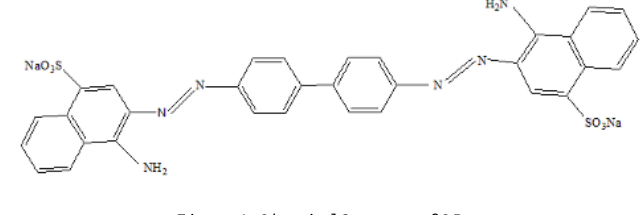
Figure. 1. Chemical Structure of